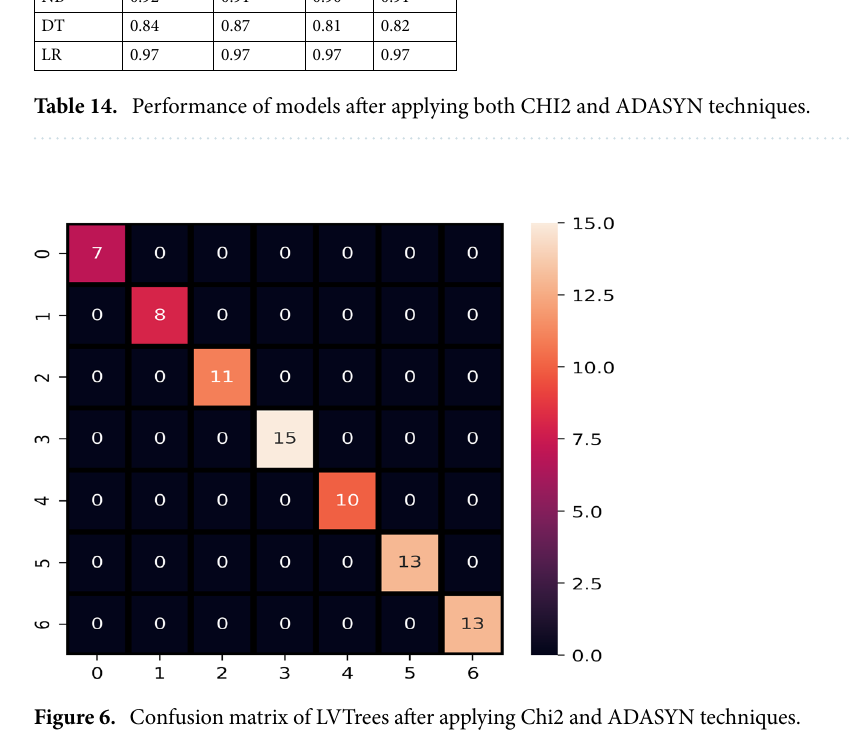
Figure 6. Confusion matrix of LVTrees after applying Chi2 and ADASYN